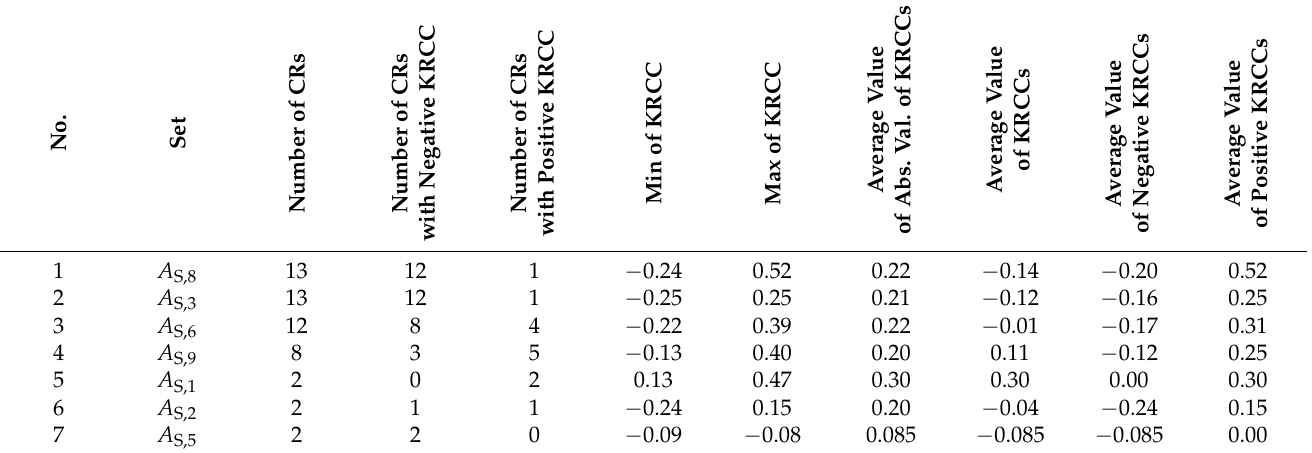
Table 7. Characteristics of SSCRs Between Nodal-Voltage Magnitudes and Nodal Reactive Powers